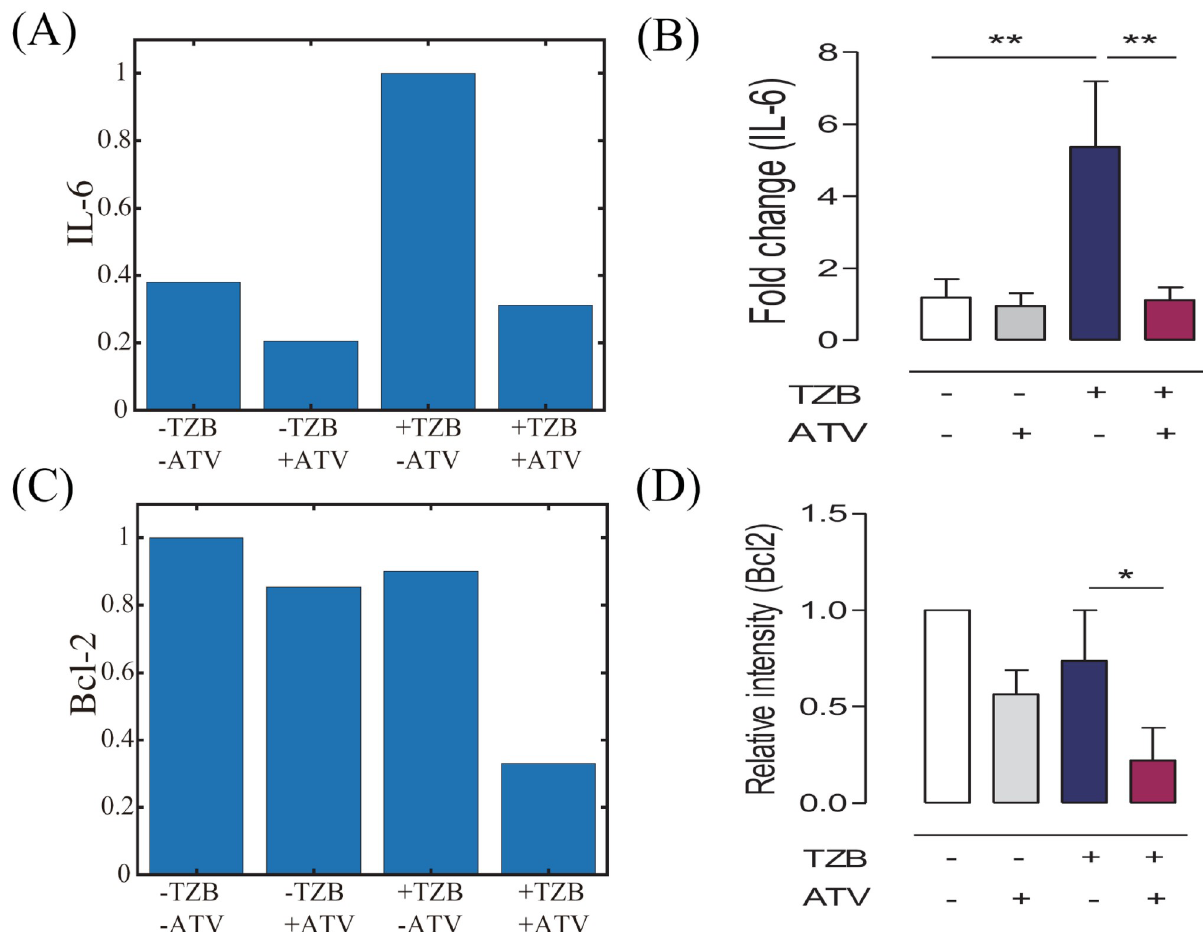
Fig 5. Comparison with experimental results. (A,C) IL-6 levels (A) and Bcl-2 expression (C) at final time ( t = 30 days ) for control (TZB − ATV − ), ATV alone (TZB − ATV + ), TZB alone (TZB + ATV − ), and combination therapy (TZB + ATV + ). (B,D) IL-6 levels (B) and Bcl-2 expression (D) were measured in experimental behavioral study [10] where the passive avoidance test was adapted for quantitative assessment of the chemical response to an aversive shock and long-term memory (figures from [10] with